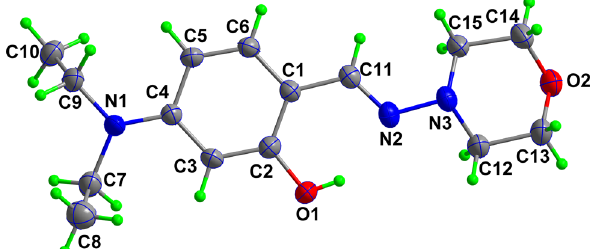
Table  : Data collection and handling.